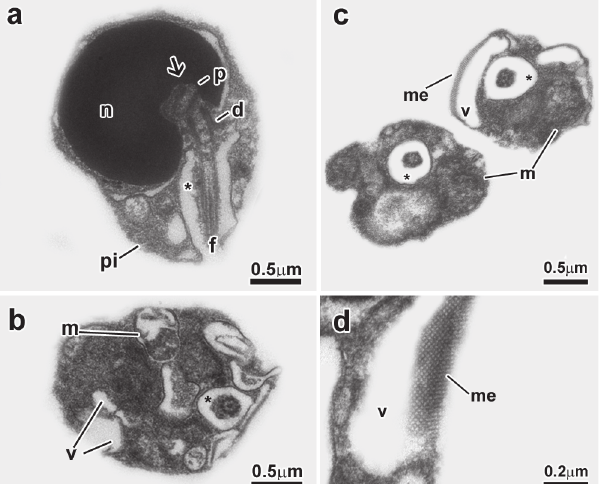
Fig. 9. Spermatozoon of Chalceus epakros . a, b: longitudinal sections. c, d: transverse sections from top to posterior region. The nucleus (n) is spherical and lies medial to the flagellum (f). The centriolar complex (p, d) and nuclear fossa (arrow) is medial. The proximal centriole (p) is in a right or oblique angle relative to the distal centriole (d). The cytoplasmic canal is present (asterisk). The midpiece (pi) is asymmetrical, and contains only one “c” shape mitochondria (m), vesicles (v) and a cytoplasmic sleeve (arrowhead). The flagellum has lateral fins (fi). Legends: cr: concentric membranous rings, d: distal centriole, e: electron-lucent areas, f: flagellum, fi: flagellar fins, m: mitochondria, n: nucleus, p: proximal centriole, v: vesicle, asterisk: cytoplasmic canal, arrow: nuclear fossa, arrowhead: cytoplasmic